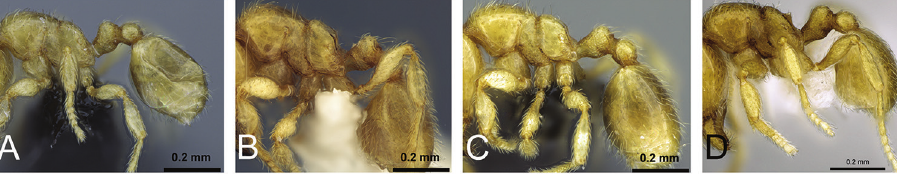
Figure 23. Body in profile view of A Carebara malagasy (CASENT0044172) B Carebara dota (CASENT0192570) C Carebara bara (CASENT0016716) D Carebara mahafaly (CASENT0410535). 7 In profile, combined outline of dorsal surface of peduncle and anterior face of node weakly concave, and outline of dorsal surface of propodeum weakly concave (Fig. 24B) ...................................................................... C. demeter